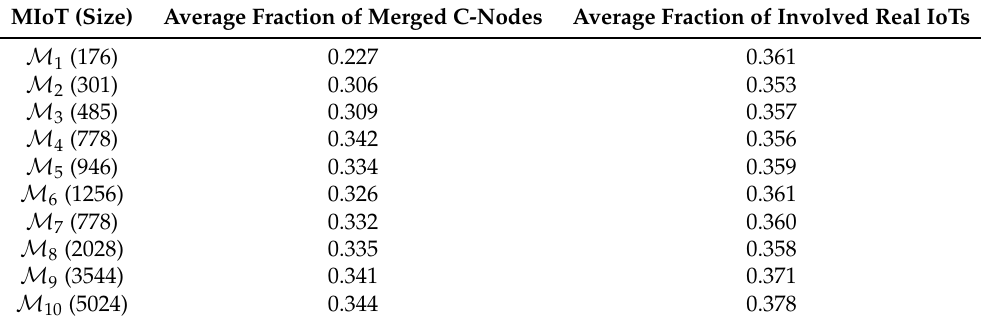
Table 7. Average fraction of merged c-nodes and average fraction of real IoTs involved in a virtual IoT against the size of MIoTs (unsupervised